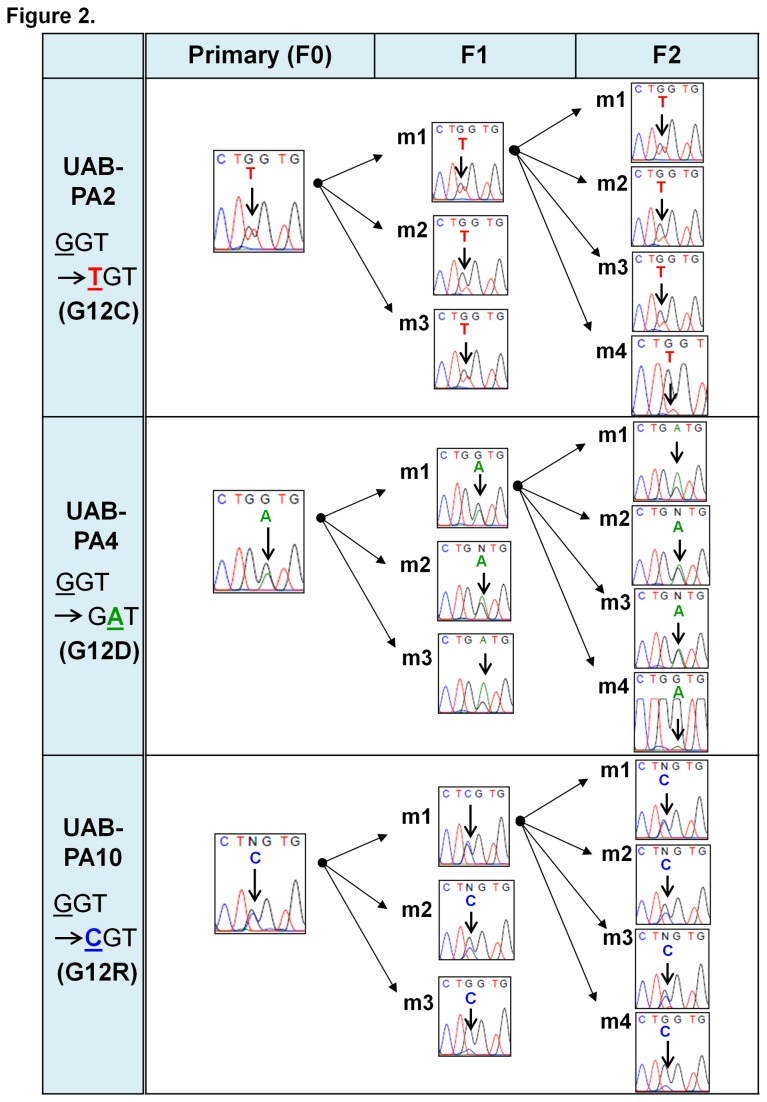
Sister tumorgrafts originating from the same F0 or F1 tumor retained KRAS codon 12 mutational status.Electropherograms demonstrate that sister tumorgrafts (from mouse 1 [m1], mouse 2 [m2], mouse 3 [m3], and mouse 4 [m4] of each set) from all three models (UAB-PA2; UAB-PA4; UAB-PA10) conserved KRAS codon 12 status in F0, F1 and F2 tumors. Experimental details are reported in Materials and Methods.